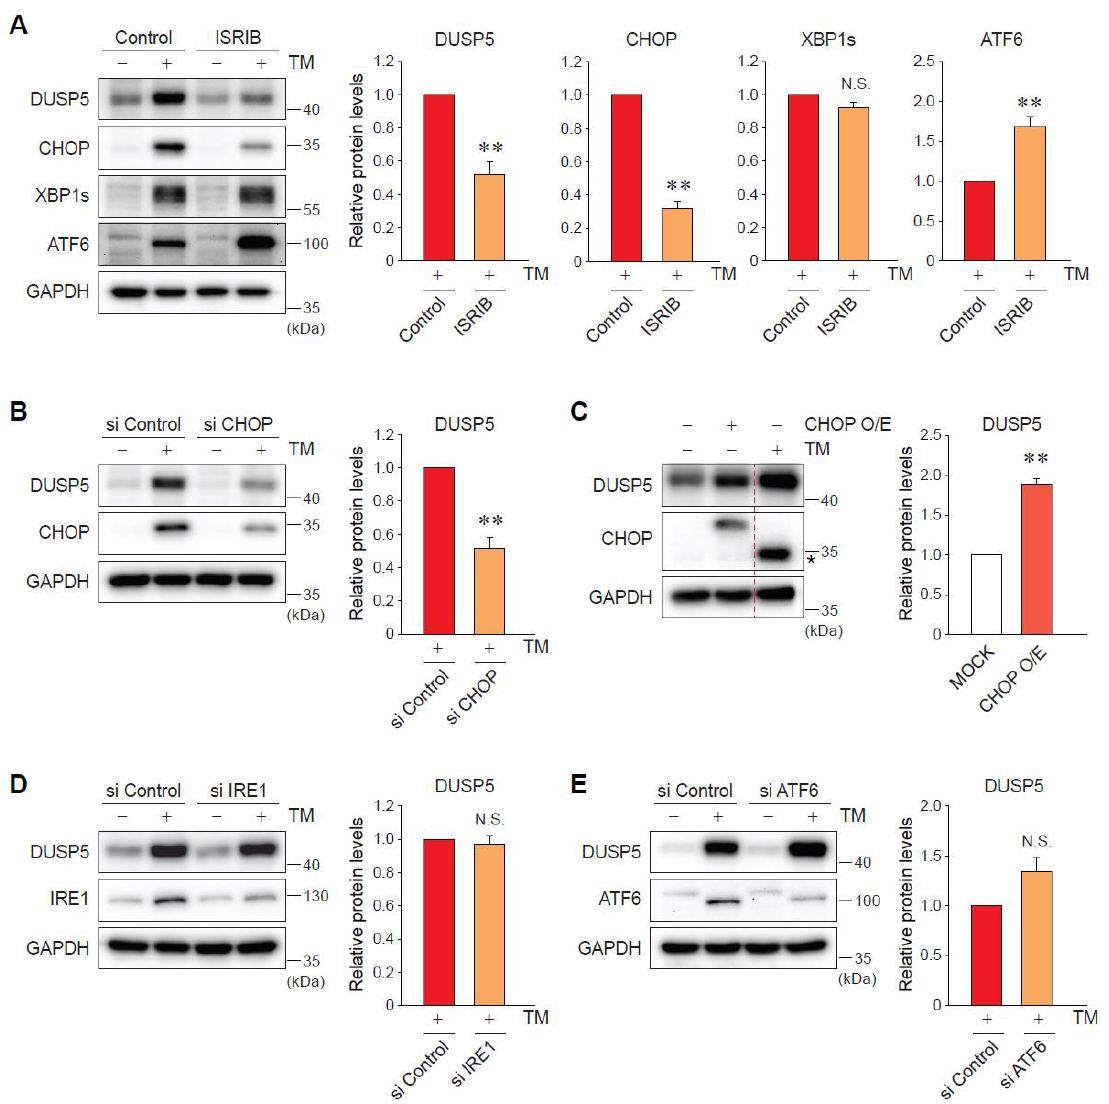
Figure 3. DUSP5 induction by ER stress is mediated by the protein kinase RNA-like endoplasmic reticulum kinase (PERK)-C/EBP homologous protein (CHOP) pathway. ( A ) Immunoblotting